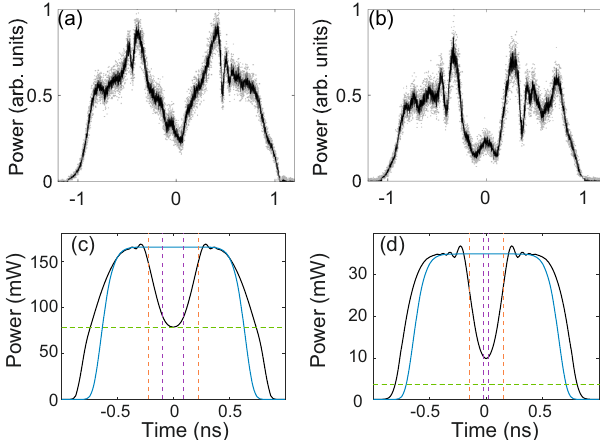
Fig. 5 Retracting piston experiment. Rarefaction wave pair produced by an increasing input jump in frequency with ± Δ f 0 = 5.4 GHz, and power: ( a ) P = 165 mW ( u = − 0.63); ( b ) P = 35 mW ( u = − 1.37). c , d Simulations 0 0 0 0 based on the NLSE. The dashed vertical lines stand for edge hydrodynamic velocities calculated from Eq. 7. The horizontal green line stands for ρ i P 0 , with ρ i from Eq. 4. The blue curves stand for the input super-Gaussian pulse pro fi le on which we superimpose the stepwise chirp jump (see Methods for